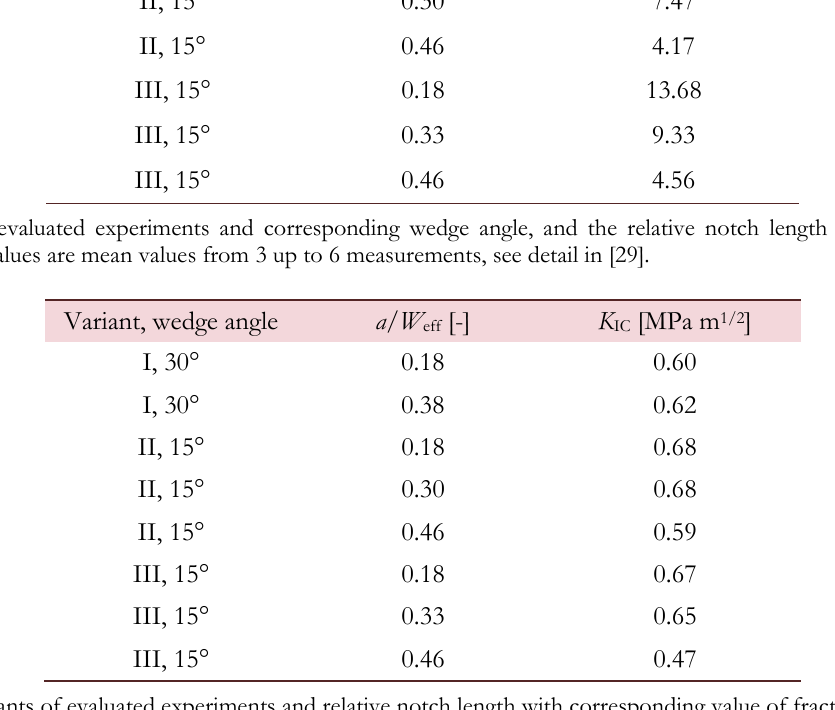
Table 4: Variants of evaluated experiments and relative notch length with corresponding value of fracture